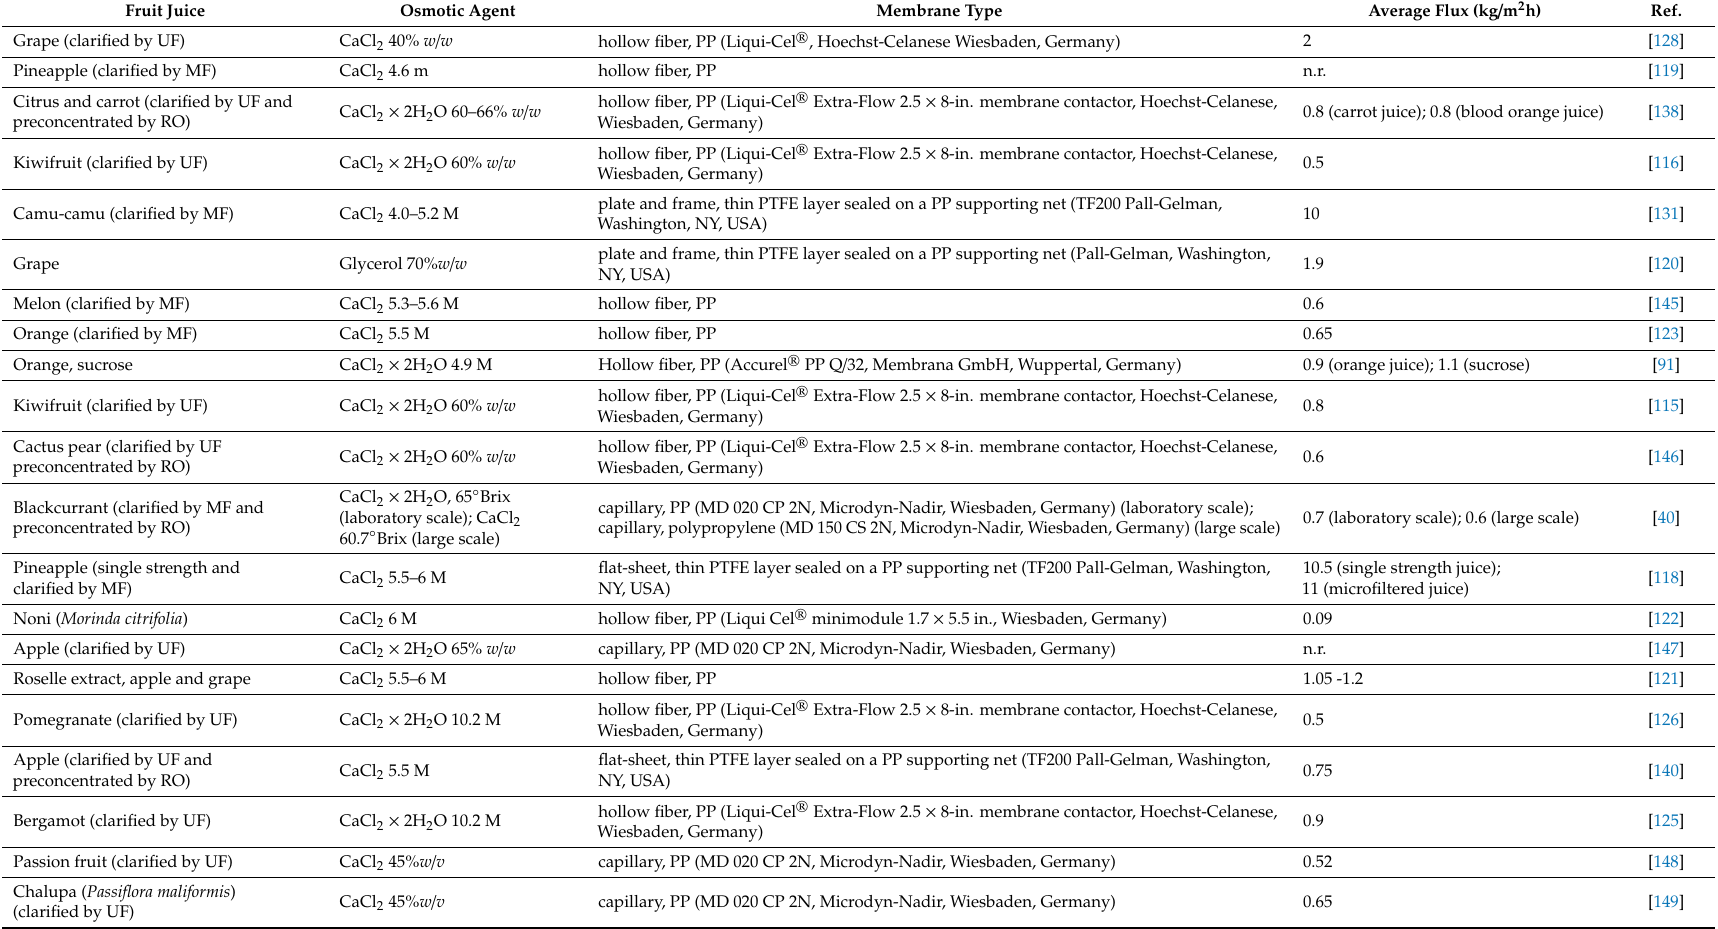
Table 5. Concentration of fruit juices by osmotic